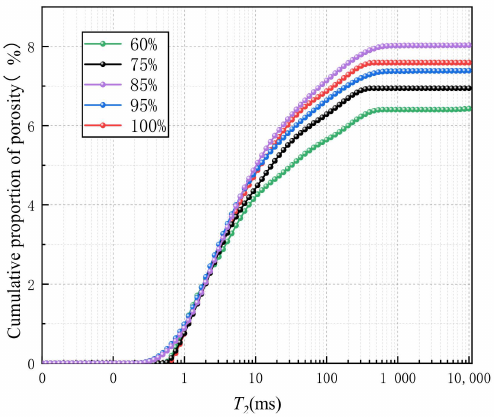
Figure 9. Porosity accumulation curve.